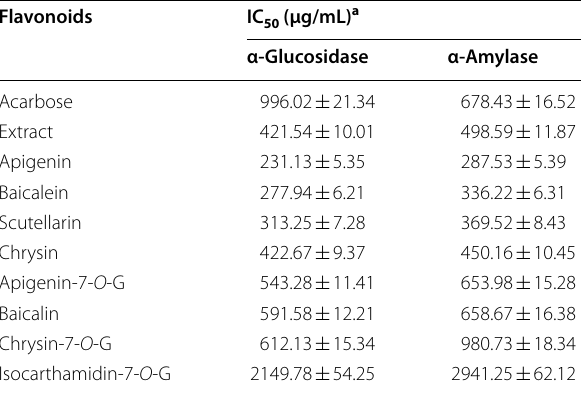
SD of three independent experiments (n ± =